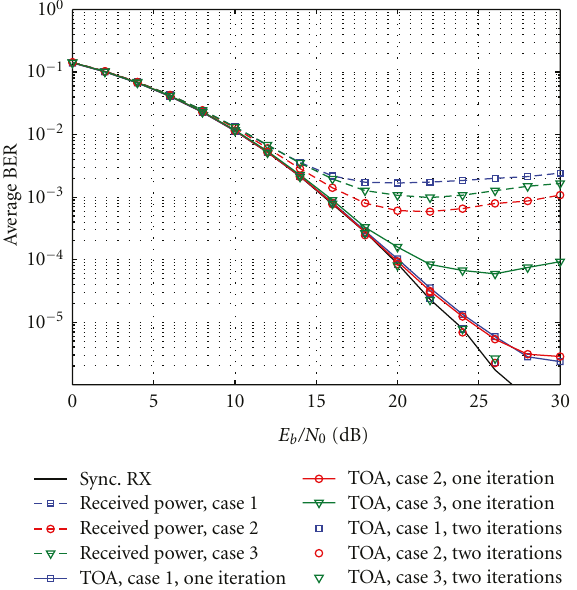
Figure 11: Average BER performance of quasi-synchronous BS- CDMA with 8 active